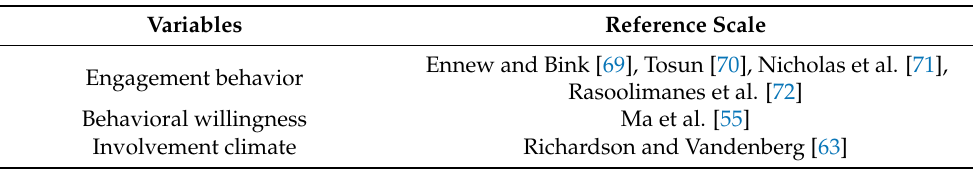
Table 1. Measurement questions and sources of